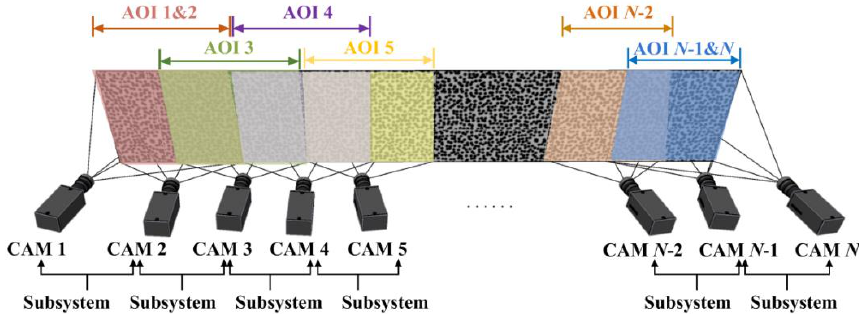
Figure 7. Second form of camera arrangement for continuous-view MC-DIC system.